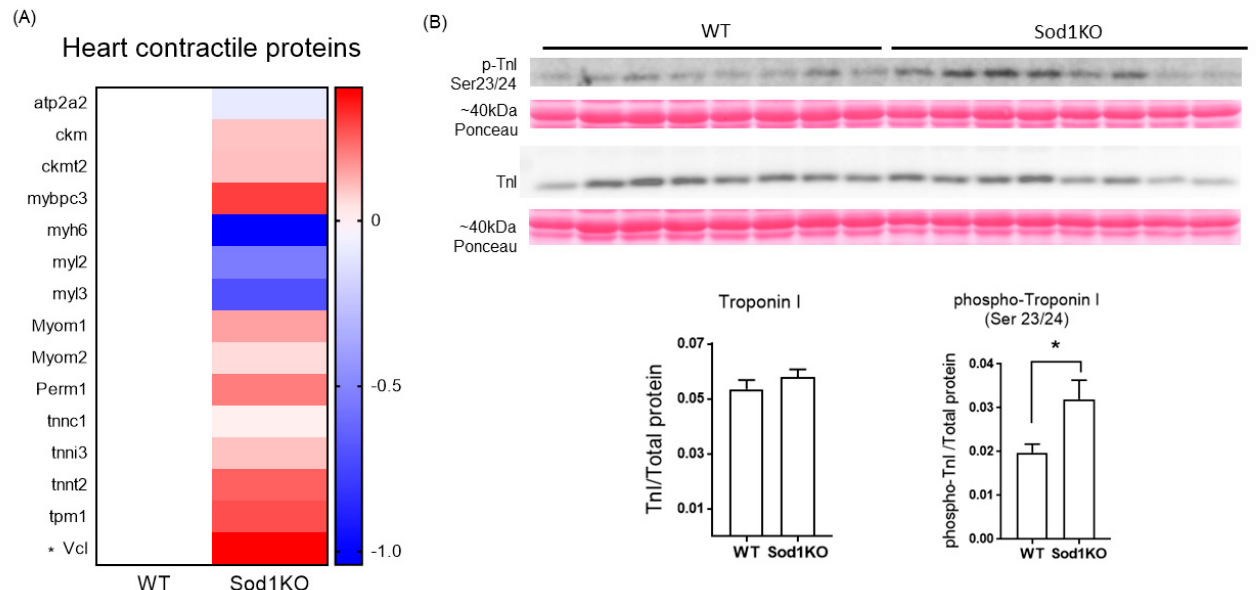
Figure 7. Heart contractile protein abundance and troponin I phosphorylation. ( A ) Heart contractile proteins determined by targeted mass spectrometry ( n = 8). ( B ) Top: Immunoblot images showing total troponin I (cTnI) and phosphorylated cTnI in heart lysates. Bottom: Quantified total cTnI and phosphorylated cTnI at Ser23 and 24 sites, normalized to total proteins ( n = 8). Data are mean ± SEM. * p < 0.05. Abbreviations: cTnI = cardiac troponin I.